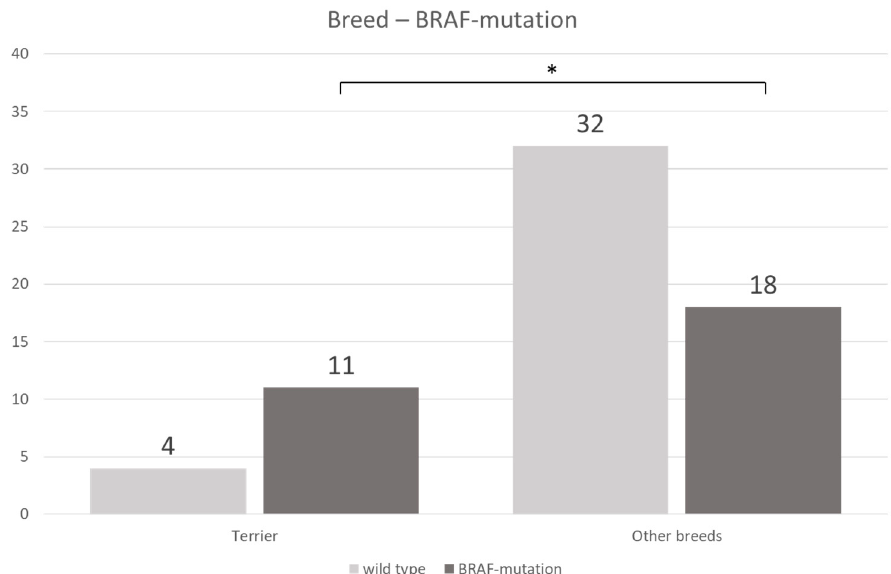
Figure 5. Correlation between breed and the presence or absence of BRAF mutation: BRAF mutation occurs significantly more often in transitional cell carcinoma in terriers than in transitional cell carcinoma in non-terriers (Fisher’s exact test, p ≤ 0.05).